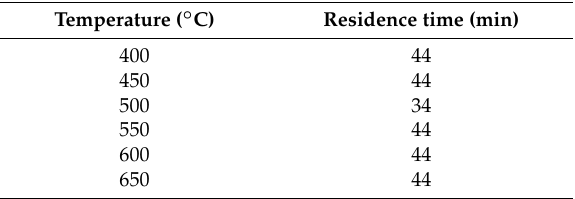
Table 1. Heating schedule during in-situ isotermal high-temperature SRD.